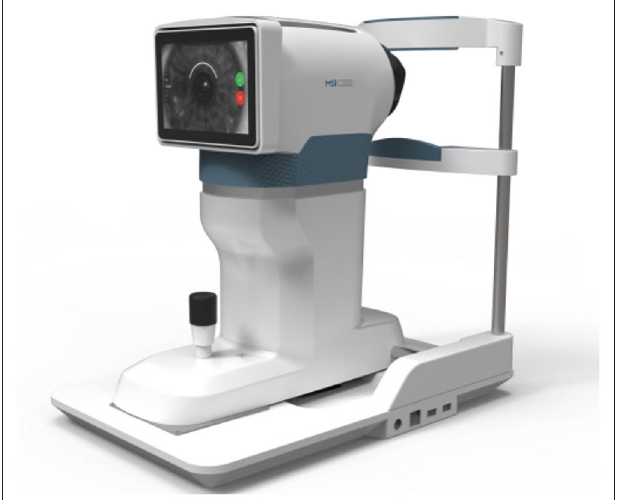
FIGURE 1 | Multispectral refractive topographic instrument. (THONDER, China).